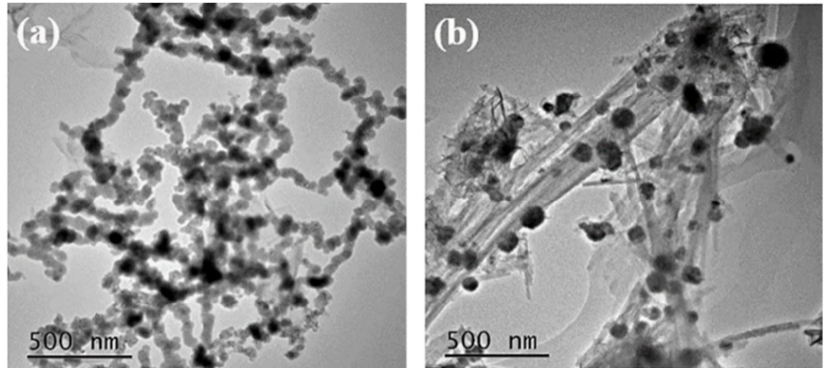
Figure 1. TEM images of nFe/Ni ( a ) and ATP-nFe/Ni ( b ).